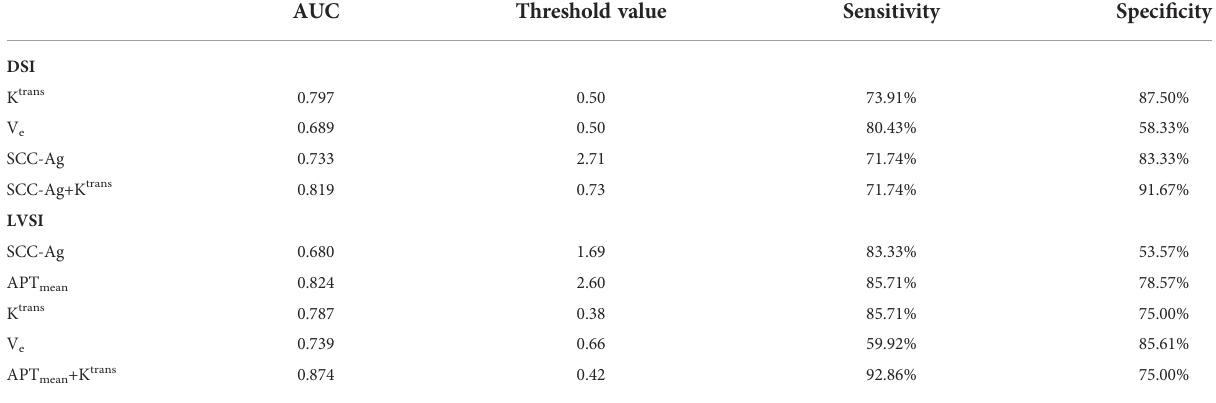
TABLE 4 Diagnostic performances of signi fi cant parameters for predicting LVSI and DSI.